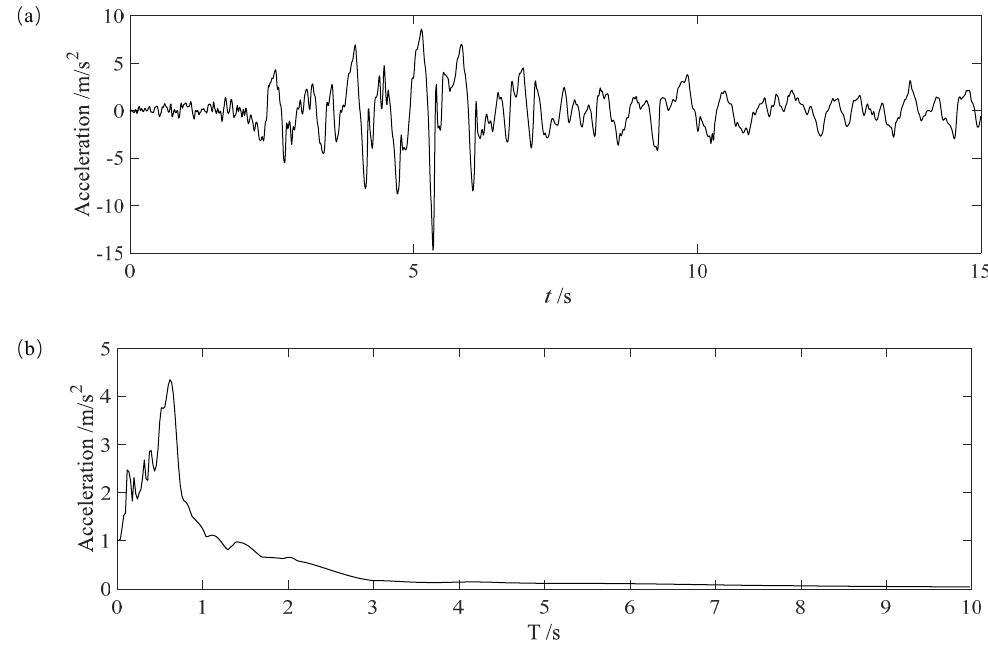
Figure 14. Spectral characteristics of Loma Prieta wave. ( a ) Time history. ( b ) Response spectrum.